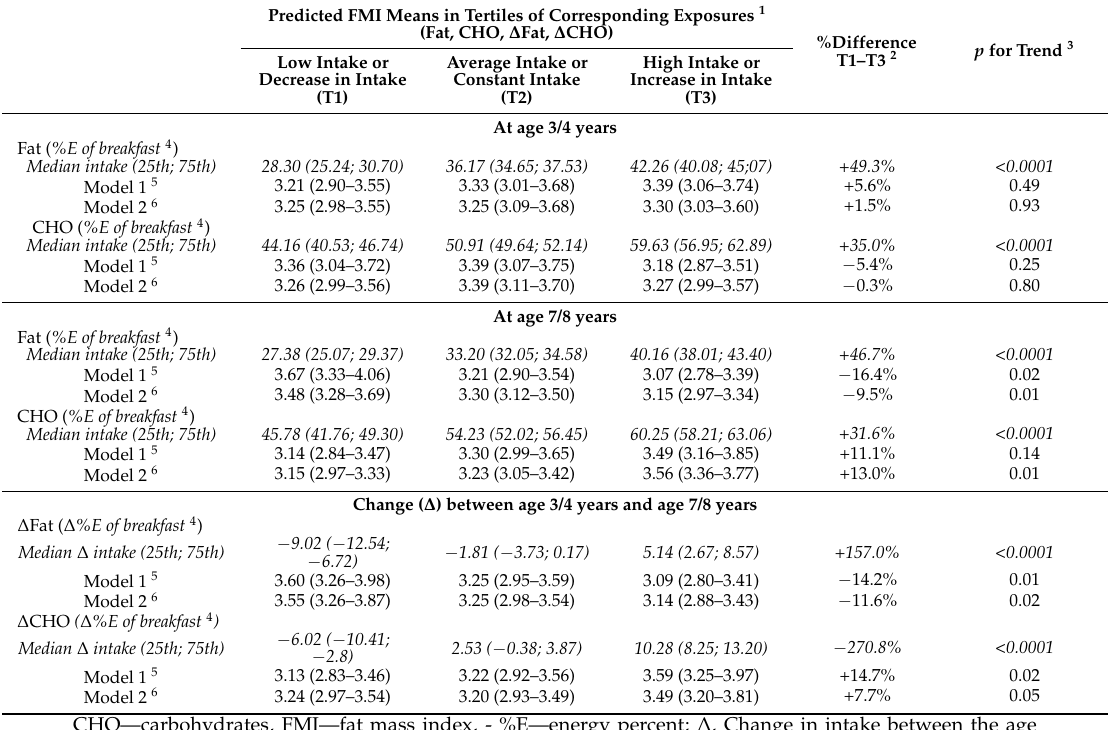
Table 3. Relation of fat and carbohydrate (CHO) intake before 11 a.m. during different critical time periods throughout childhood to FMI in early adolescence at age 10/11 years (in-depth analysis sample, N =